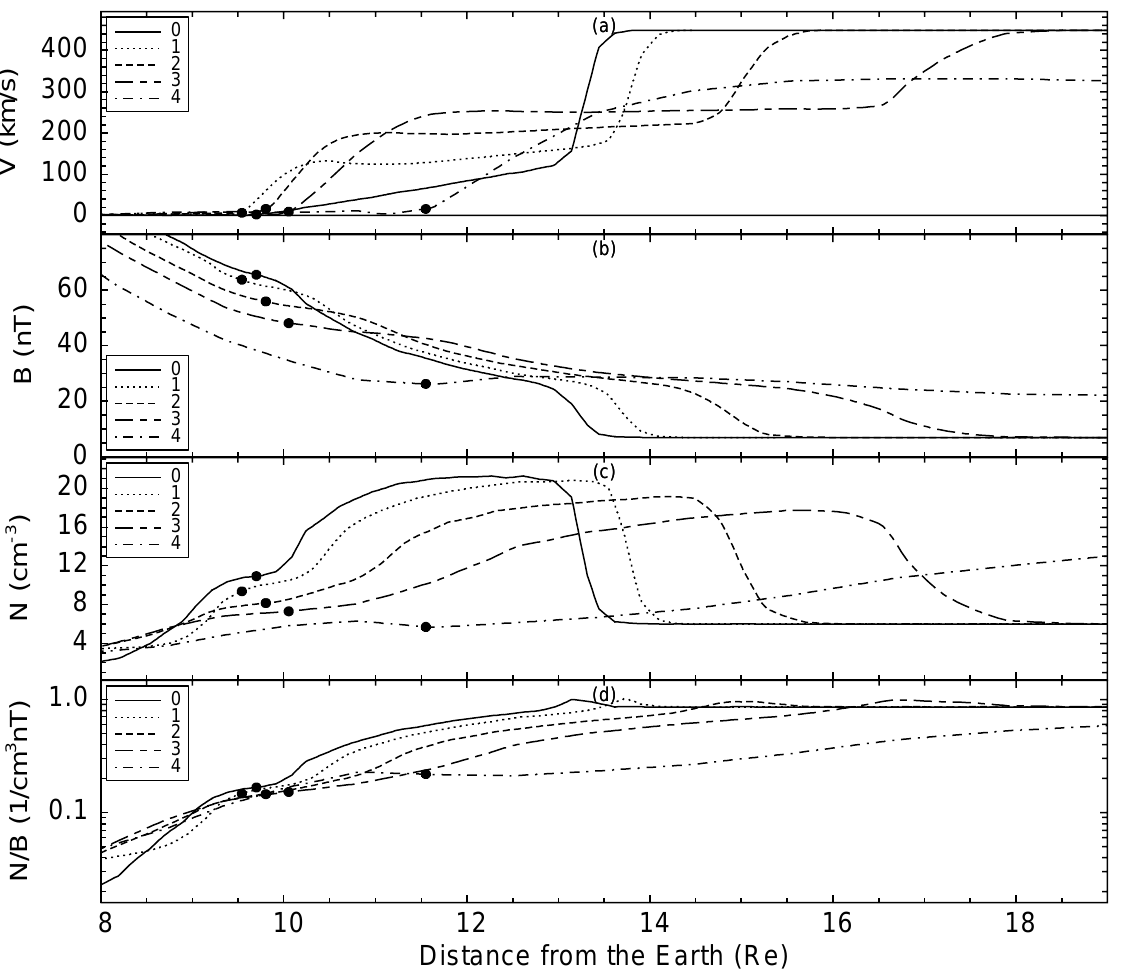
Fig. 4. Parameters along the radial straight lines in the z =0 plane in Fig. 2. From top to bottom are the flow velocity, the magnetic field magnitude, the plasma density, and the ratio between the plasma density and the magnetic field magnitude (N/B). The magnetosphere is on the left side of the figure, the solar wind is on the right side of the figure, and the magnetosheath is between the magnetosphere and the solar wind. The magnetopause is defined as the boundary where the magnetosheath flow velocity is close to zero. The magnetopause locations on lines 0–4 are shown as black